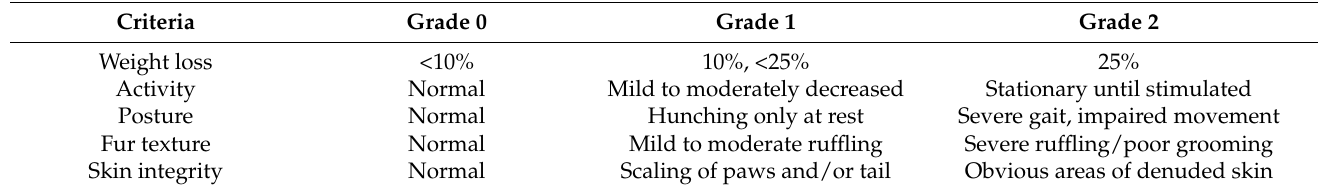
Table 1. Graft versus host disease scoring system.